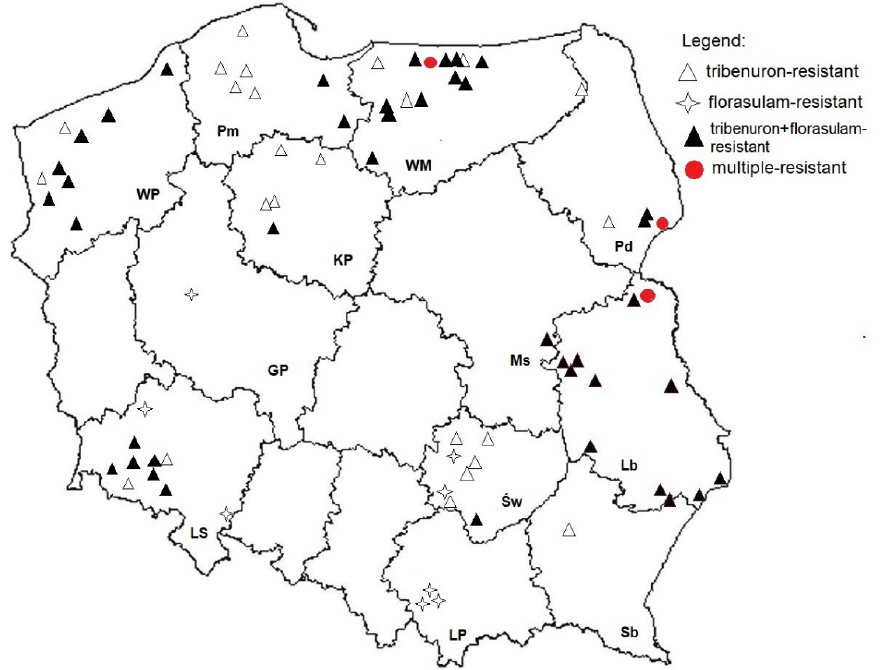
Figure 2. Locations in Poland where herbicide-resistant populations of Centaurea cyanus L. were found. Abbreviations: GP—Greater Poland; KP—Kuyavia-Pomerania; LP—Lesser Poland; LS— Lower Silesia; Lb—Lublin; Ms—Masovia; Pd—Podlasie; Pm—Pomerania; Sb—Subcarpathia; Ś w— Ś wi ę tokrzyskie; WM—Warmia-Masuria; WP—West Pomerania. The C. cyanus populations were also tested for their sensitivity to auxinic herbicides.